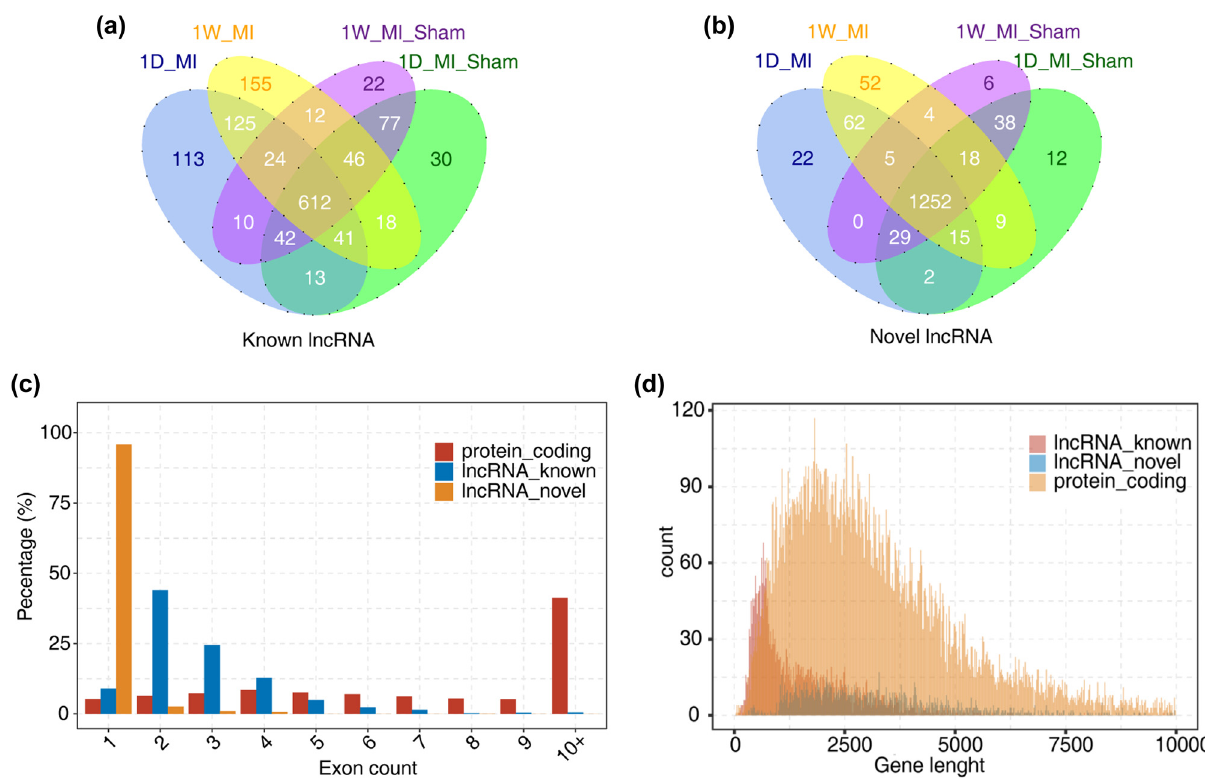
Figure 2: Characteristics of lncRNAs detected in MI and sham samples. Venn diagram of detected known lncRNAs ( a ) and novel lncRNAs ( b ) in MI and sham samples. lncRNAs that were detected ( RPKM ≥ 0.2 ) in at least two samples were considered to be detected in the group. ( c ) Distribution of exon counts of known lncRNAs, novel lncRNAs, and protein - coding RNAs. ( d ) Density of the length distribution of known lncRNAs, novel lncRNAs, and protein - coding RNAs. The length density distribution was generated by the density function in